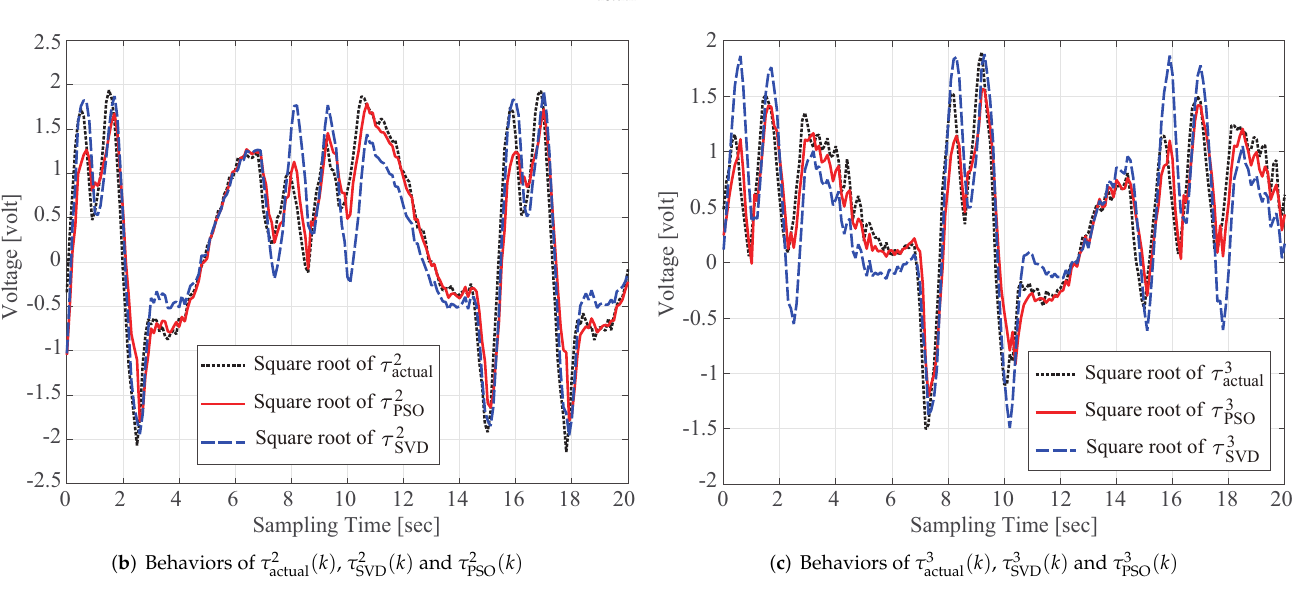
Figure 9. Comparison of the measured actual torque τ actual , the torque τ i based identification, and the torque τ i in